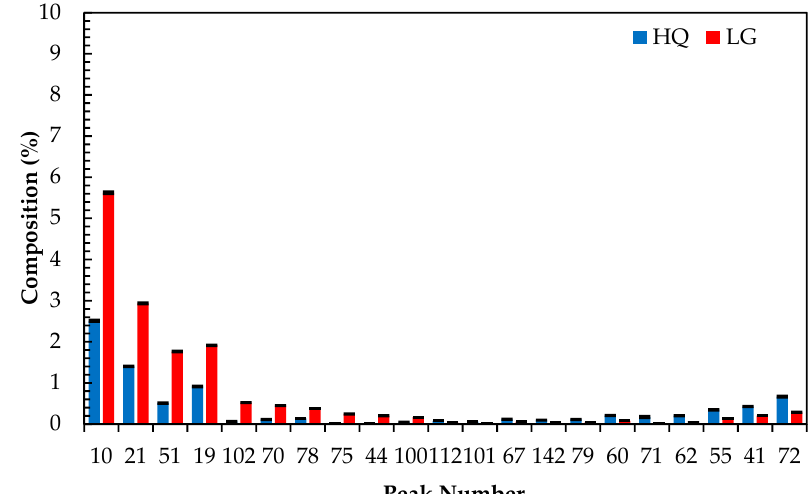
Figure 5. Top 15 significant peak features identified in the volcano plot of the analyzed lavender oil samples by untargeted GC-MS.